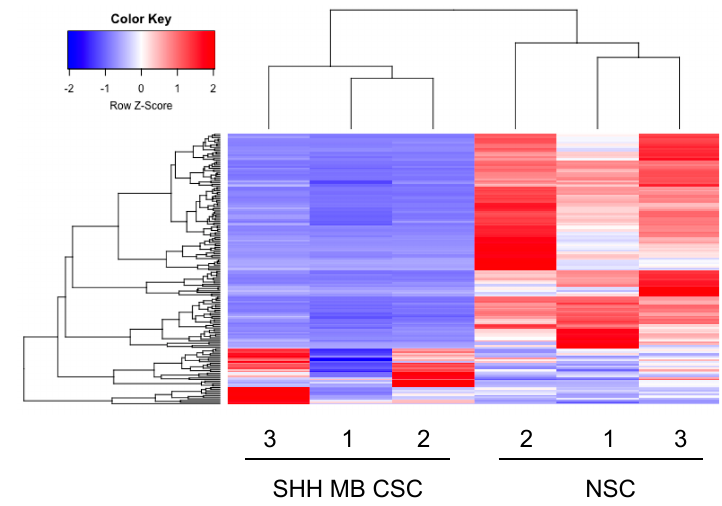
Figure 1. miRNA-sequencing determines miRNA signatures in Sonic Hedgehog Medulloblastoma Cancer Stem Cells (SHH MB CSCs). Heat map and dendrogram depiction of the 168 miRNAs displaying significant differential expression in SHH MB CSCs and Neural Stem Cells (NSCs).